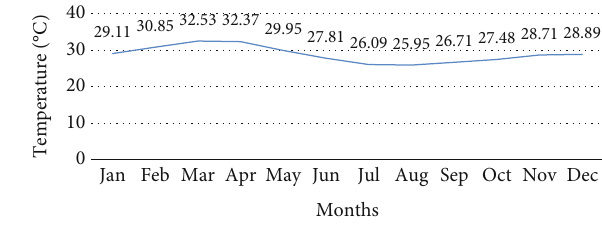
Figure 41: Monthly temperature variation ( ° C) for South